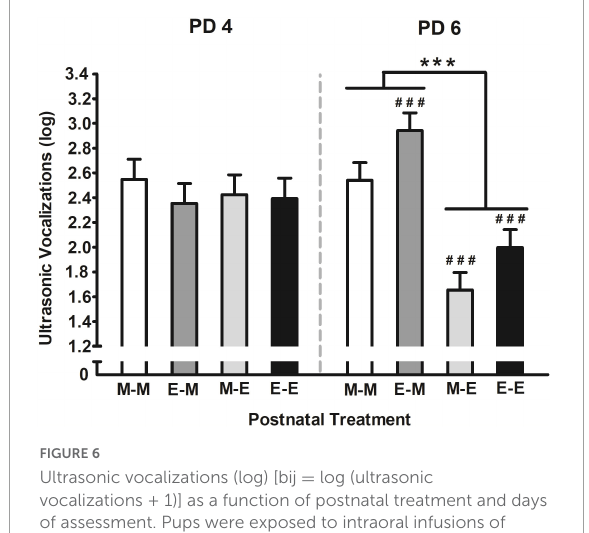
FIGURE6 Ultrasonic vocalizations (log) [bij = log (ultrasonic vocalizations + 1)] as a function of postnatal treatment and days of assessment. Pups were exposed to intraoral infusions of either milk (M), or ethanol mixed with milk (E) on each day of assessment (PDs 4 or 6). Four groups were defined as a function of these infusions across days: M-M, M-E, E-M, or E-E. ### p < 0.001 indicates that vocalizations on PD 6 are significantly different from those observed on PD 4 at each given group. *** p < 0.001 indicates the differences among the groups that received ethanol mixed with milk (E-E and M-E groups) relative to those that received milk (E-M and M-M) at PD6. Vertical lines illustrate standard errors of mean (SEMs).